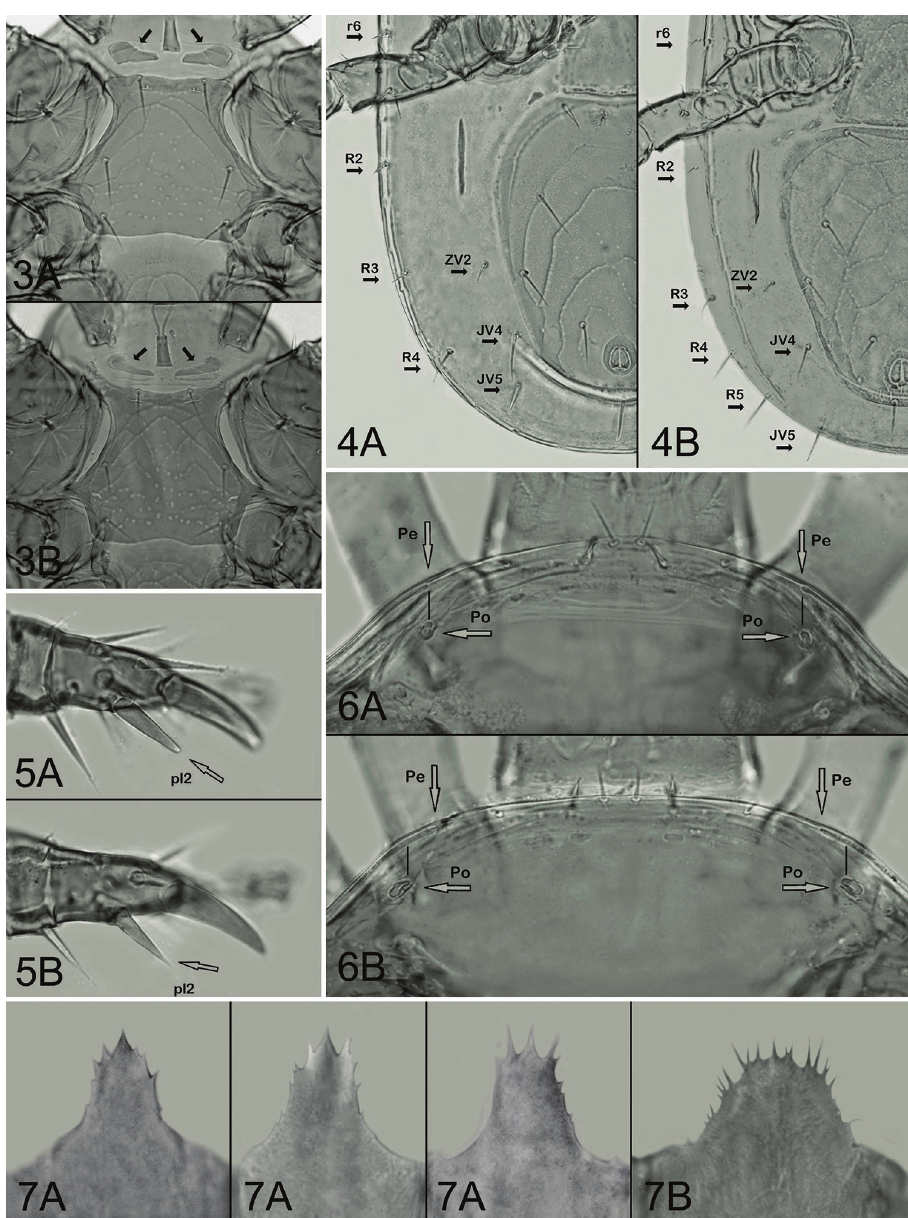
Figures 3−7. Pachyseius humeralis ( A ) and Pachyseius subhumeralis sp. n. ( B ), females. 3 Sternal re- gions (arrows pointing to presternal platelets) 4 Opisthogastric regions (arrows pointing to marginal and opisthogastric setae placed on soft integument) 5 Tarsi II (arrows pointing to seta pl2) 6 Anteriormost portion of dorsal shields [arrows pointing to anterior tip of peritremes (Pe) and enlarged gland pores gdj3 (Po)] 7 Epistomes (with three variant forms in P. humeralis ). Not to